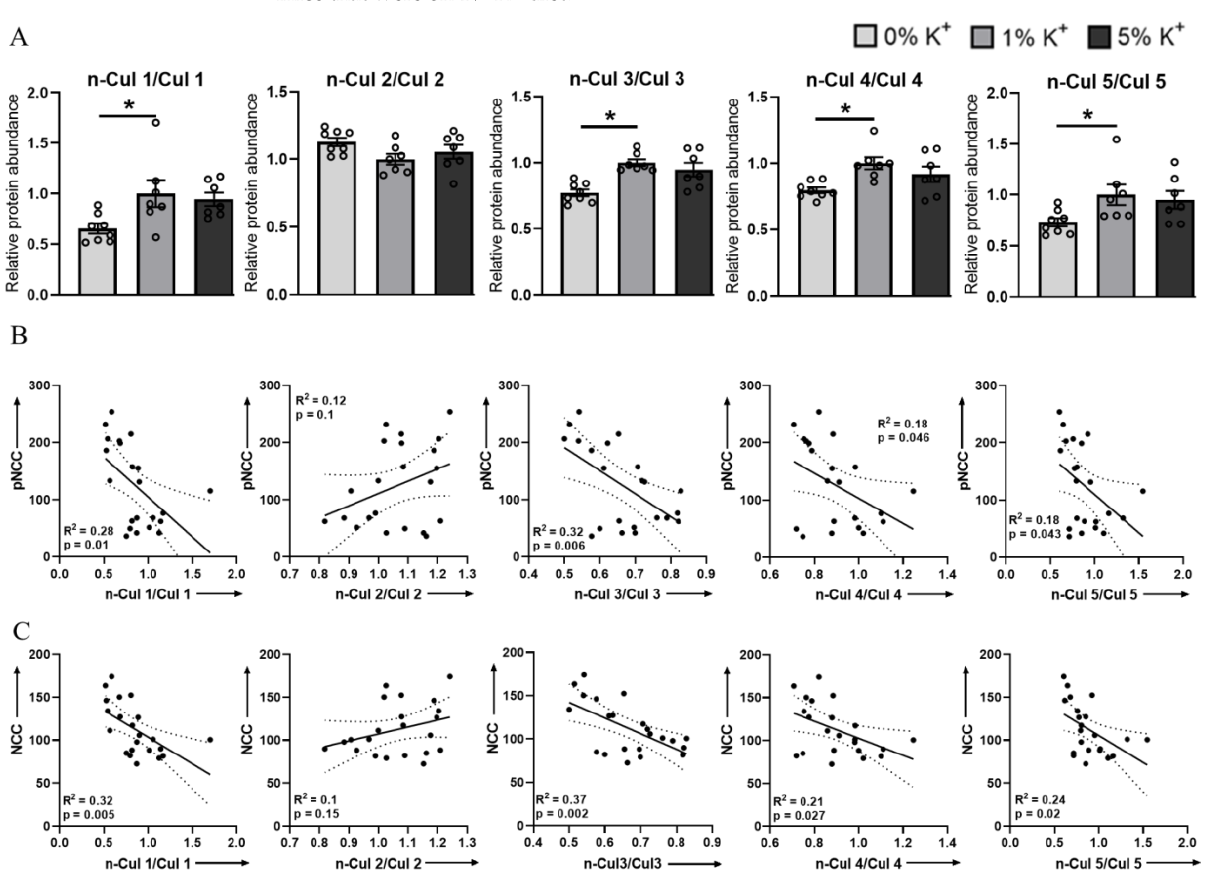
Figure 2. Low dietary K + supplementation decreases neddylation levels of Cul1, 3, 4, and 5. ( A ) Summary data of relative abundances of neddylated to non-neddylated form of Cul1, 2, 3, 4, and